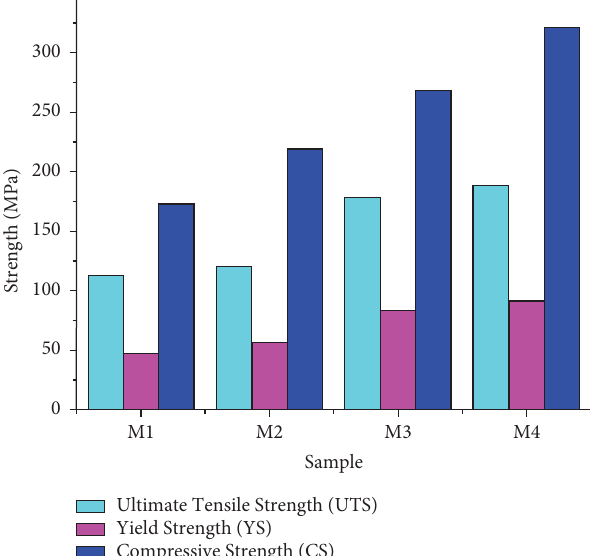
Figure 8: Variation of strength of nanocomposites.